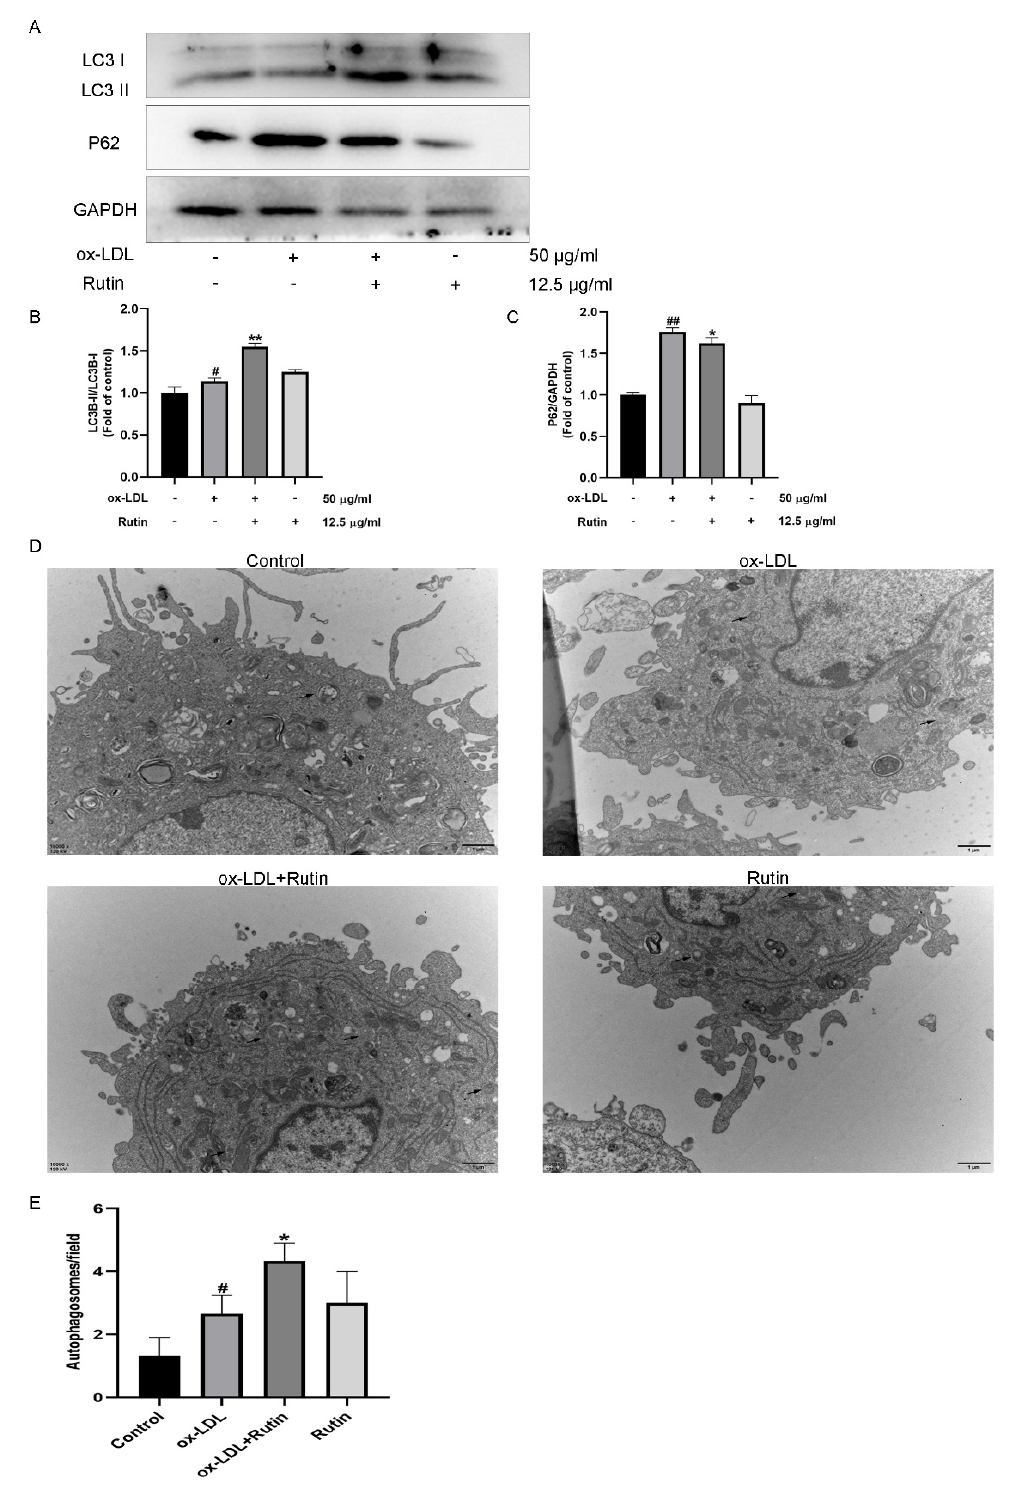
Figure 3. Rutin can promote autophagy in macrophages. RAW264.7 cells were stimulated for 24 h with 12.5 µ g/mL rutin with or without 50 µ g/mL ox-LDL therapy. ( A – C ) Western blot was used to detect the levels of LC3II/LC3I, P62 protein expression. ( D , E ) Representative TEM images and quantification of autophagosomes (arrows) in each group. # p < 0.05, ## p < 0.01 vs. control group; * p < 0.05, ** p < 0.01 vs. ox-LDL-treated group. The data are presented as mean ± SD.